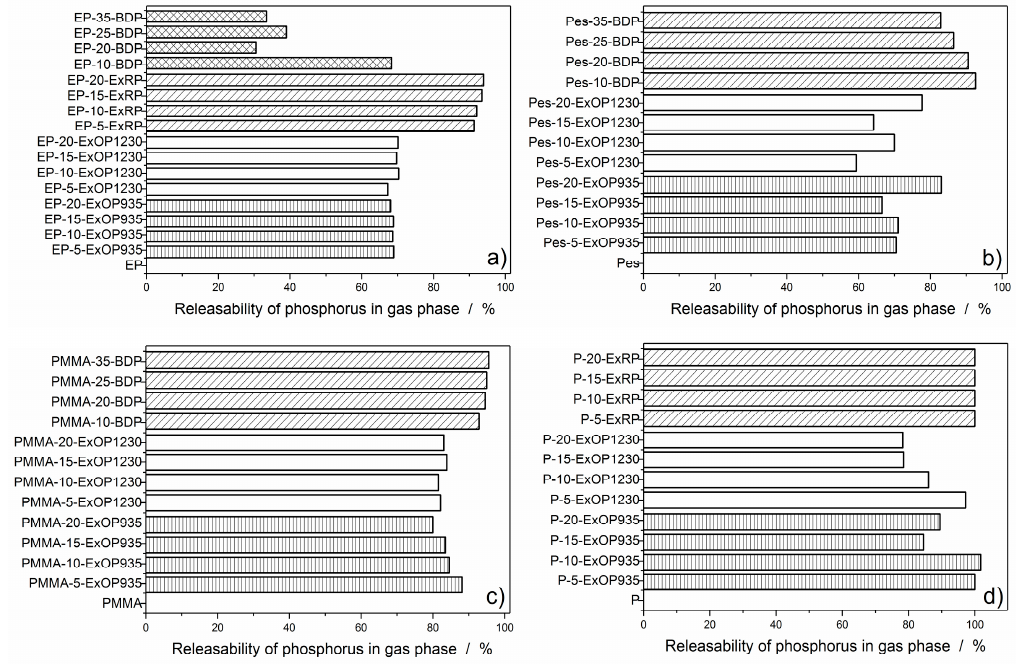
Figure 5. Bar graphs of the percentage of phosphorus released in the gas phase during combustion for epoxy resin ( a ); polyester resin ( b ); PMMA resin ( c ); and paraffin ( d ) formulations. In the epoxy resin, there were no differences in phosphorus release between Exolit OP935 and OP1230. At any flame retardant load in the sample, around 70% of the phosphorus was released into the gas phase. Phosphorus release at 10 wt % flame retardant load was similar to that of the AlPi flame retardants at any concentration, but with increasing BDP load, this amount was significantly reduced to less than half of the phosphorus released into the gas phase. Red phosphorus released over 90% of its phosphorus into the gas phase and showed a slight increase with increasing flame retardant load (Figure 5a).